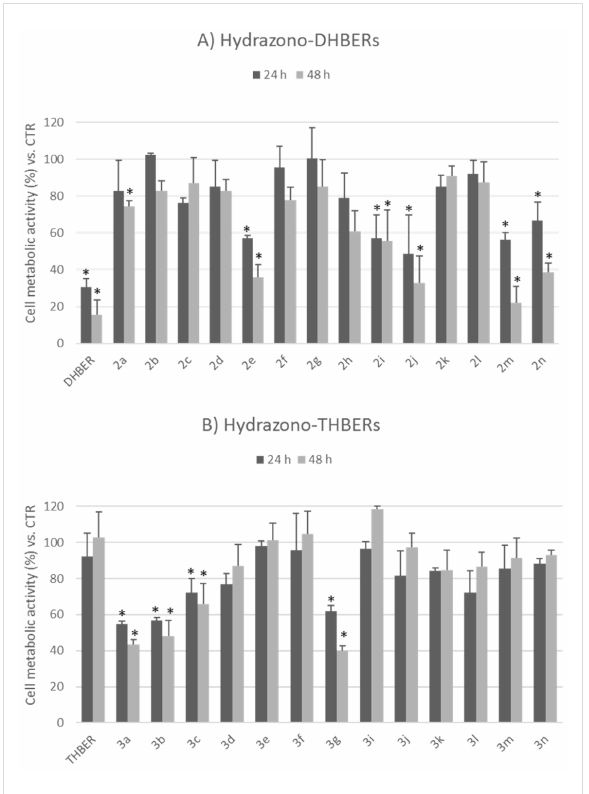
Figure 5: Effects of 25 µM hydrazono-DHBERs 2a–n (A) and hydra- zono-THBERs 3a–g,i–n [70] (B) on NCI-H1975 cell proliferation as evaluated by WST-8 assay (estimating cell metabolic activity) at 24 h and 48 h of treatment. Data are expressed as mean ± SD ( n = 3). * p < 0.05 vs CTR (DMSO